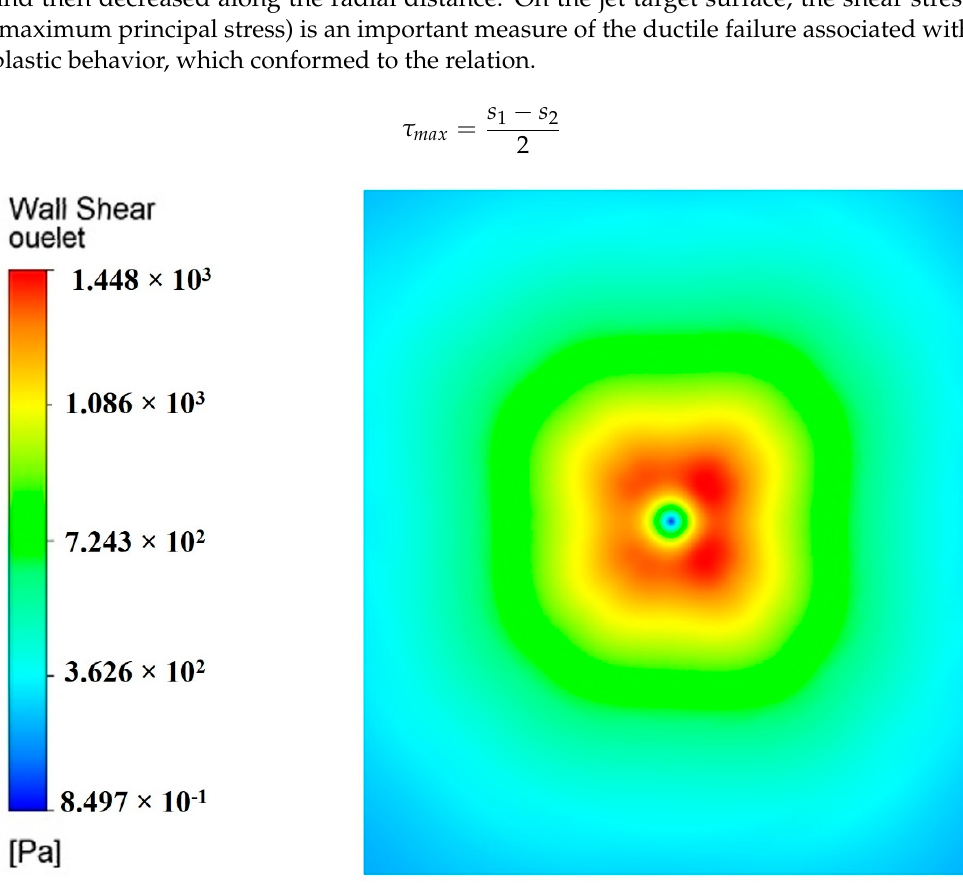
Figure 7. Wall shear stress cloud.